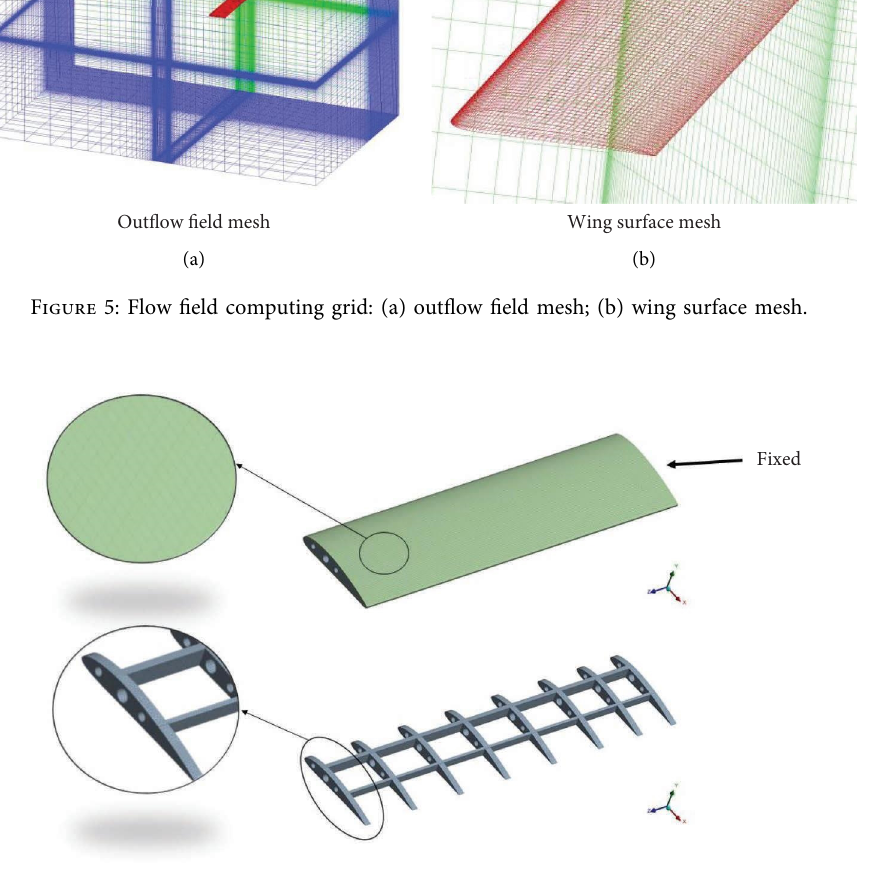
Figure 6: Structural computing